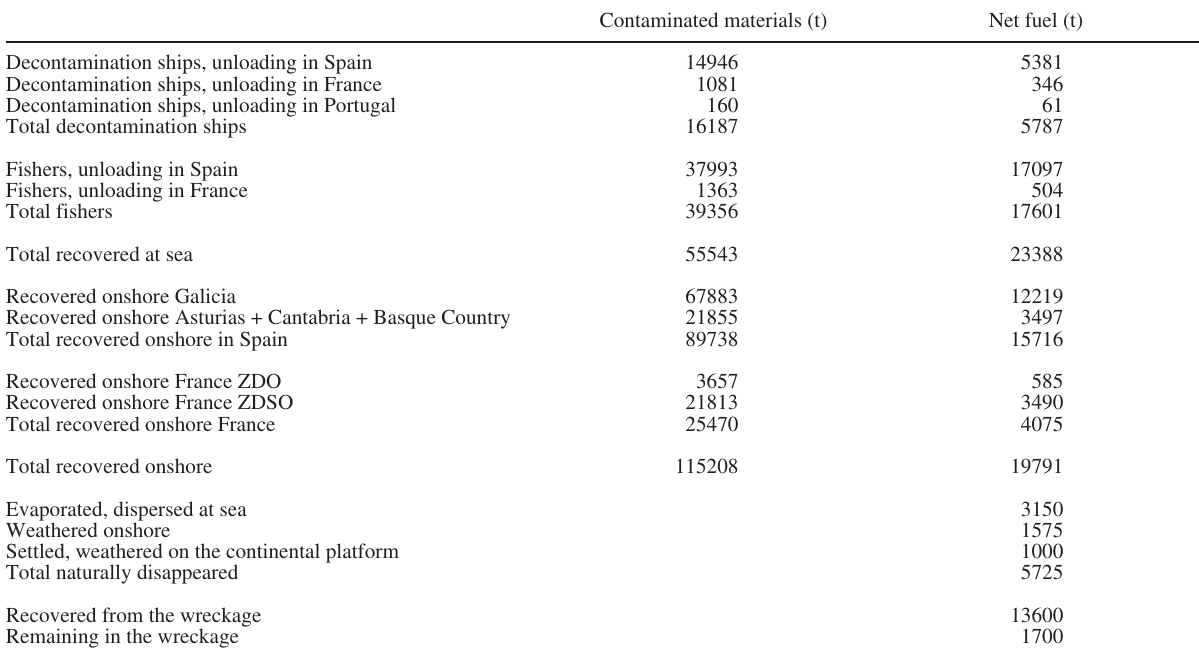
Table 3. – Distribution of quantities (tons) estimated jointly by Le Cedre and the Spanish Institution for Sea Security